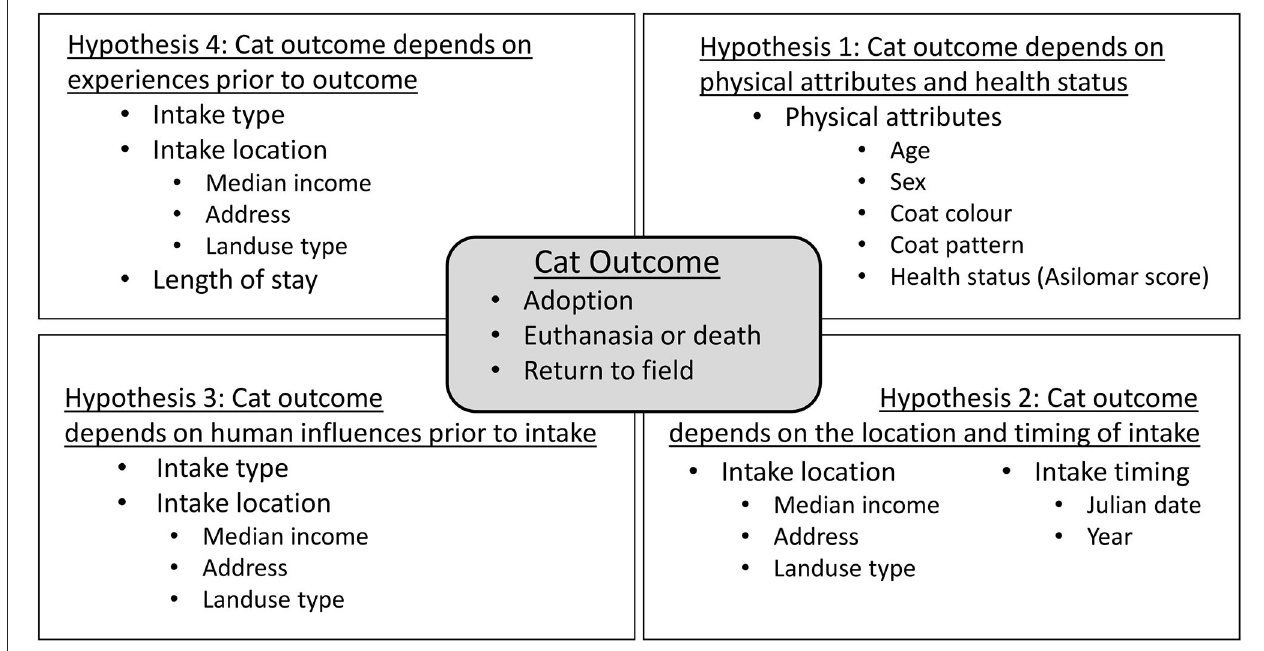
FIGURE 1 | Summary of hypotheses describing the factors used to predict cat